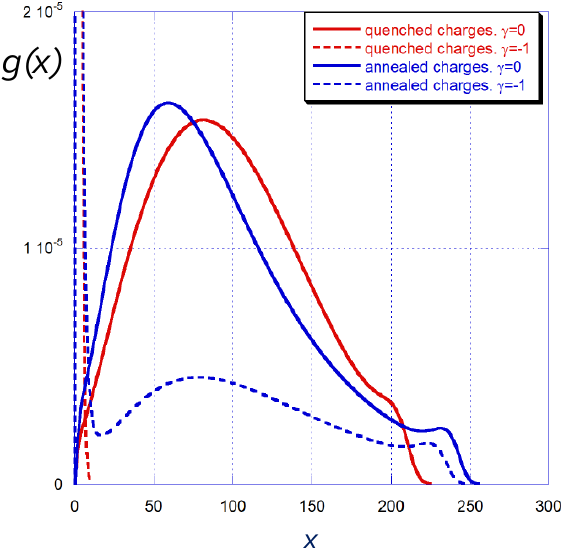
Figure 6. Distribution of the free chain ends in strong (red lines) and weak (blue lines) polyelectrolyte brushes grafted to a neutral surface (solid lines) and to the oppositely charged surface (dashed lines, γ = − 1). The average fraction of charged monomer units in strong and weak polyelectrolyte brushes at zero surface charge is the same and corresponds to α = (cid:104) α (cid:105) = 0.5. Other parameters: N = 300, a 2 / s = 0.001, salt concentration c s a 3 = 10 − 5